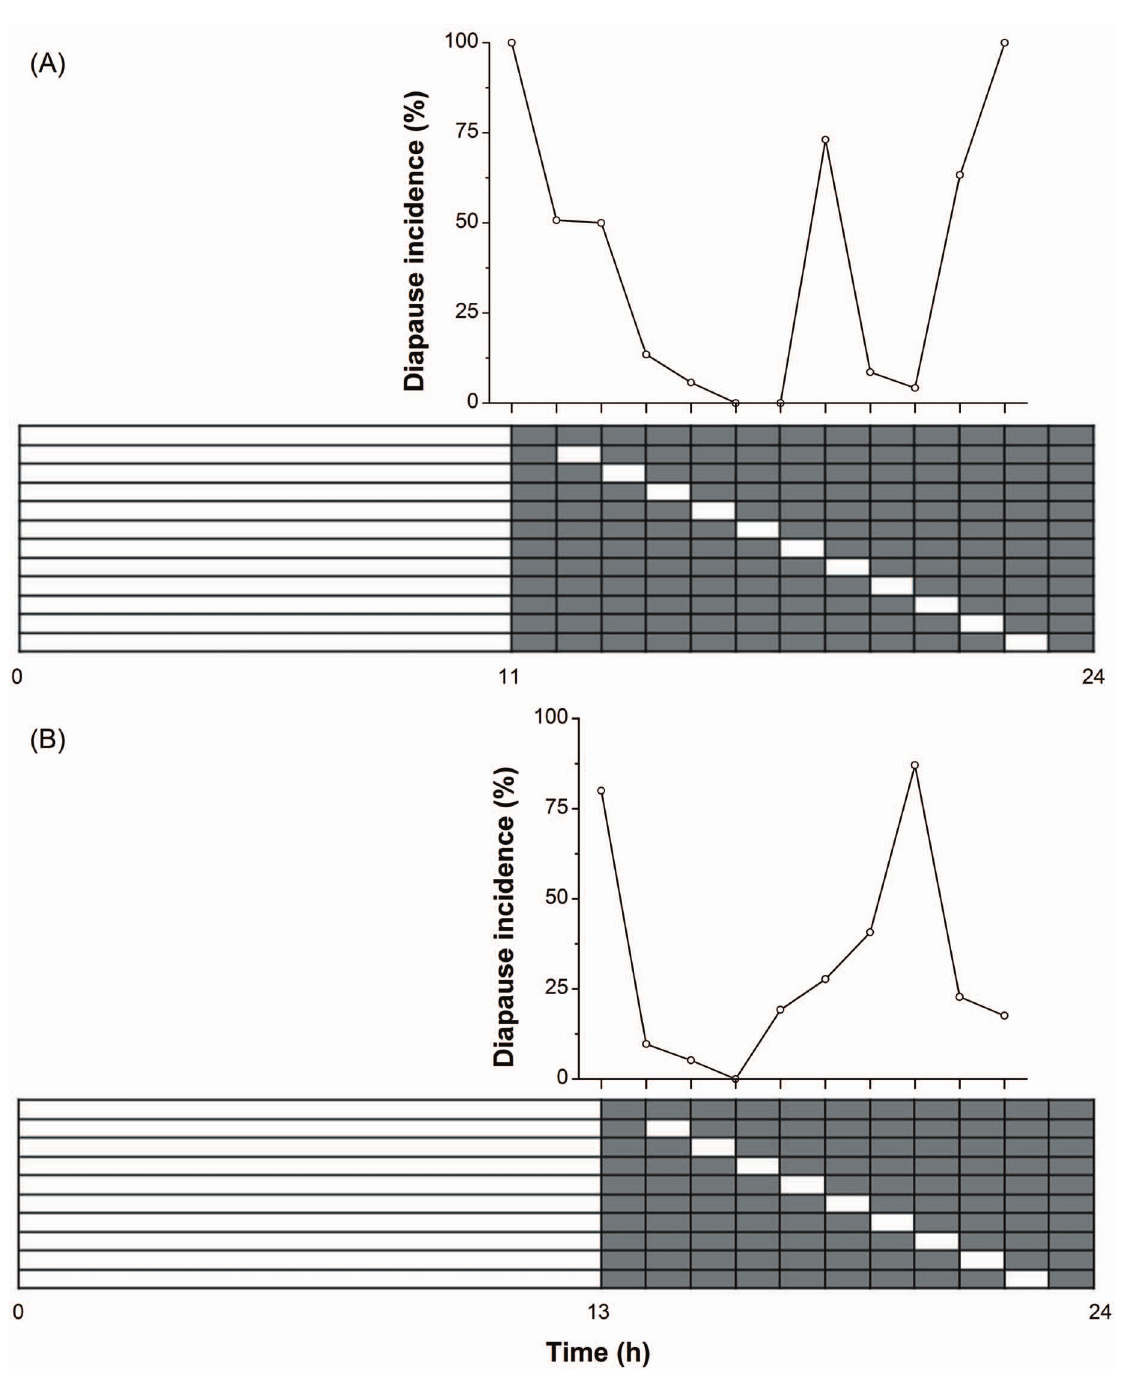
Figure 3. Night interruption for the induction of diapause in H.cunea under LD 11:13 h (A) and LD 13:11 h (B), 28 u C regimes. The scotophase was systematically scanned by 1-h light pulse. (3 replicates, each of at least 30 individuals/treatment; total n=37–198 for each point).